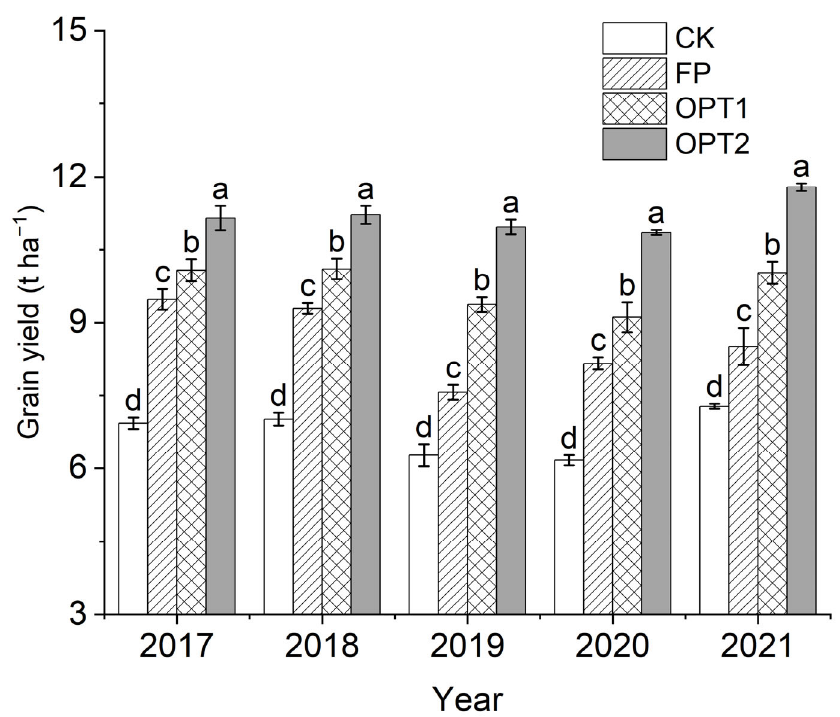
Figure 1. Grain yield of four management systems from 2017 to 2021 in Jingzhou, Hubei Province, China. Means followed by the same letter do not significantly differ (LSD, p < 0.05).